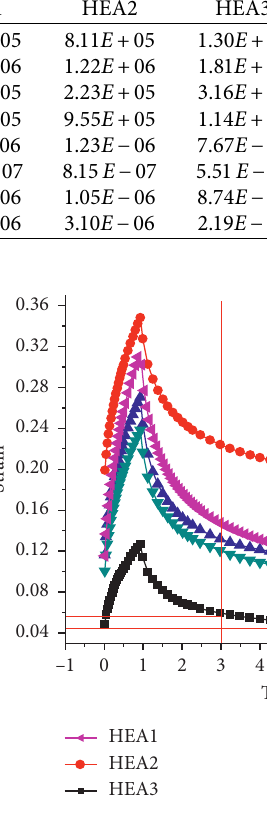
Figure 6: Creep-recovery response of five-type high-elasticity modified